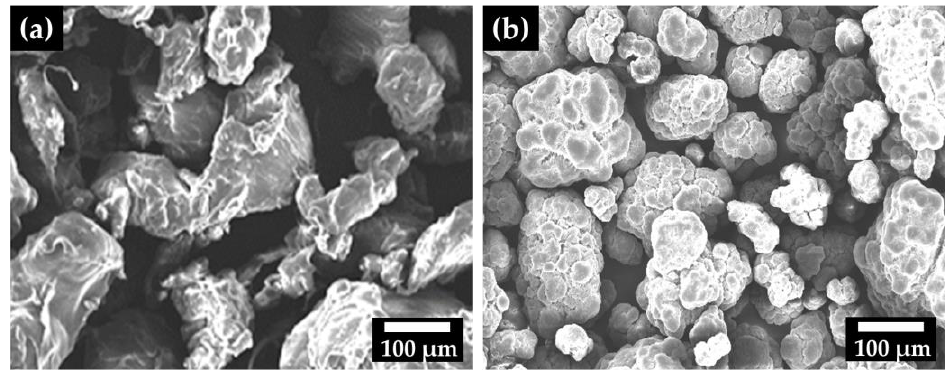
Figure 1. Particle size distribution of LLDPE and UHMWPE.